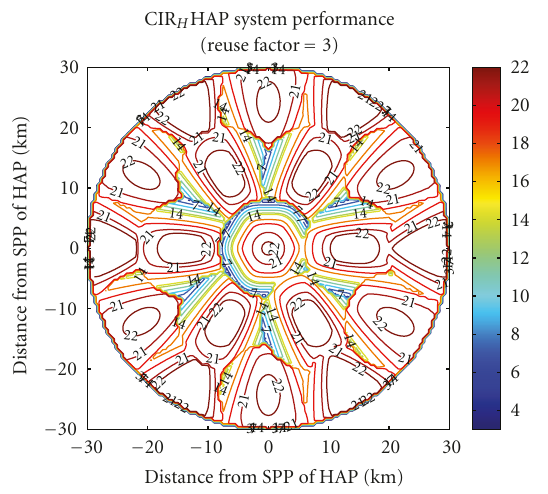
Figure 8: CIR performance of a HAP WiMAX system with reuse factor = 3.